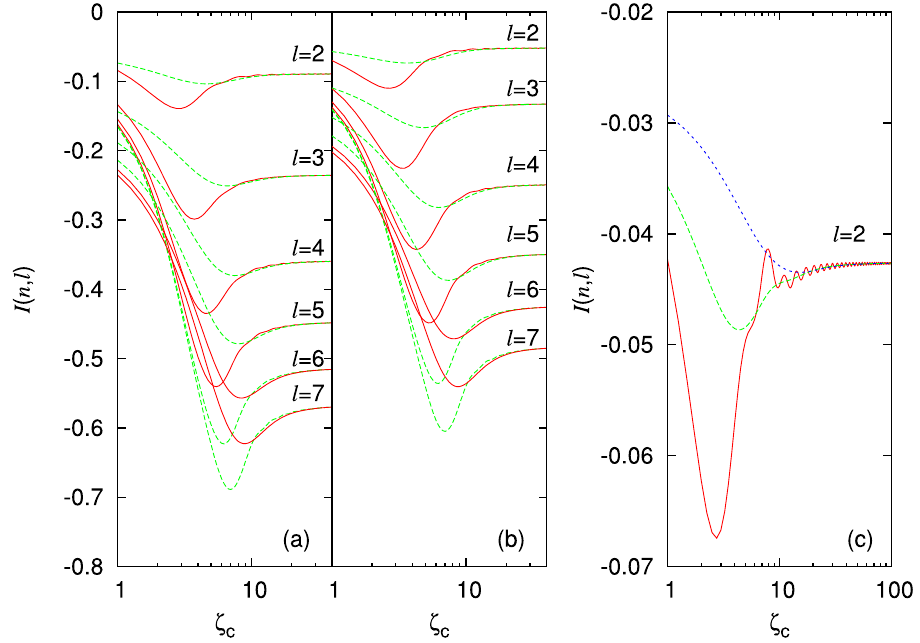
1 (red solid curves), 2 (green long dash) = 1 ; ( b ) n 2 ; and ( c ) n 10 (note the different scales on the third plot). We = = =